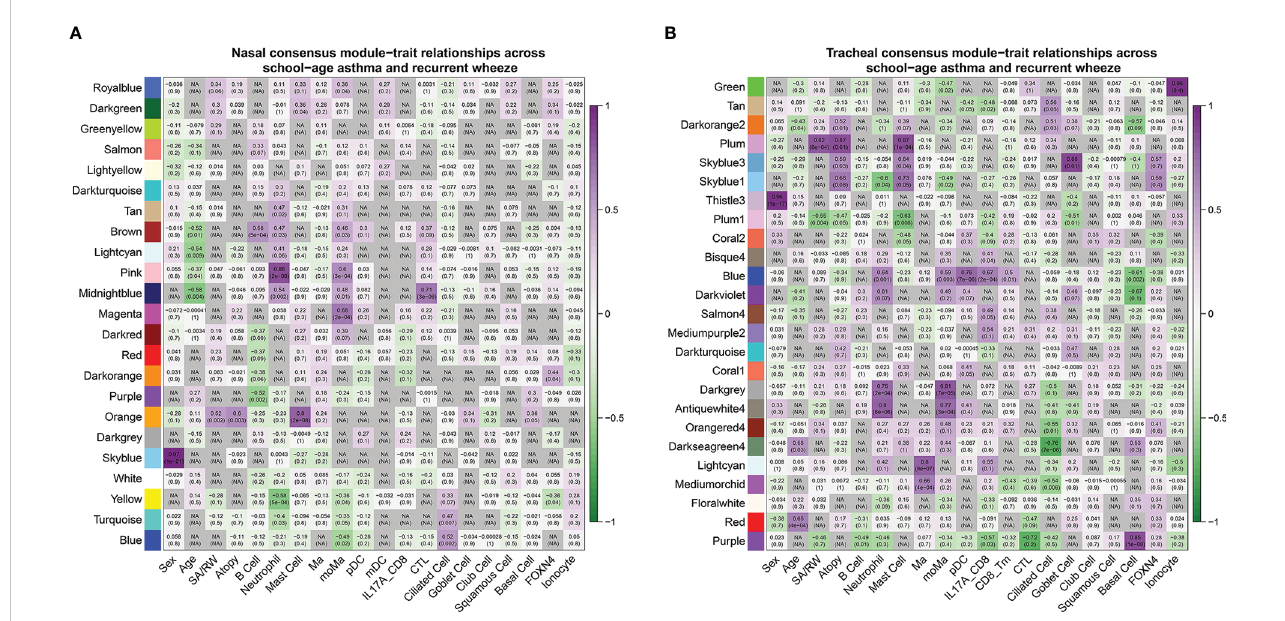
FIGURE 5 Consensus module-trait relationships across RW and SA in nasal (A, B) tracheal networks. Each module is represented by its eigengene value and Pearson correlation analysis between eigengene values and clinical traits was performed. Each color represents one consensus gene module. Each row corresponds to a module eigengene, and each column to a clinical trait. Each cell contains corresponding Pearson correlation coef fi cient ( fi rst number) and P -value (number in parenthesis). Green to purple gradient coloration implies increased Pearson correlation coef fi cient. Nasal orange module and tracheal plum module were signi fi cantly positively associated with RW, SA, atopy, and mast cells. RW, recurrent wheezing; SA, school-age